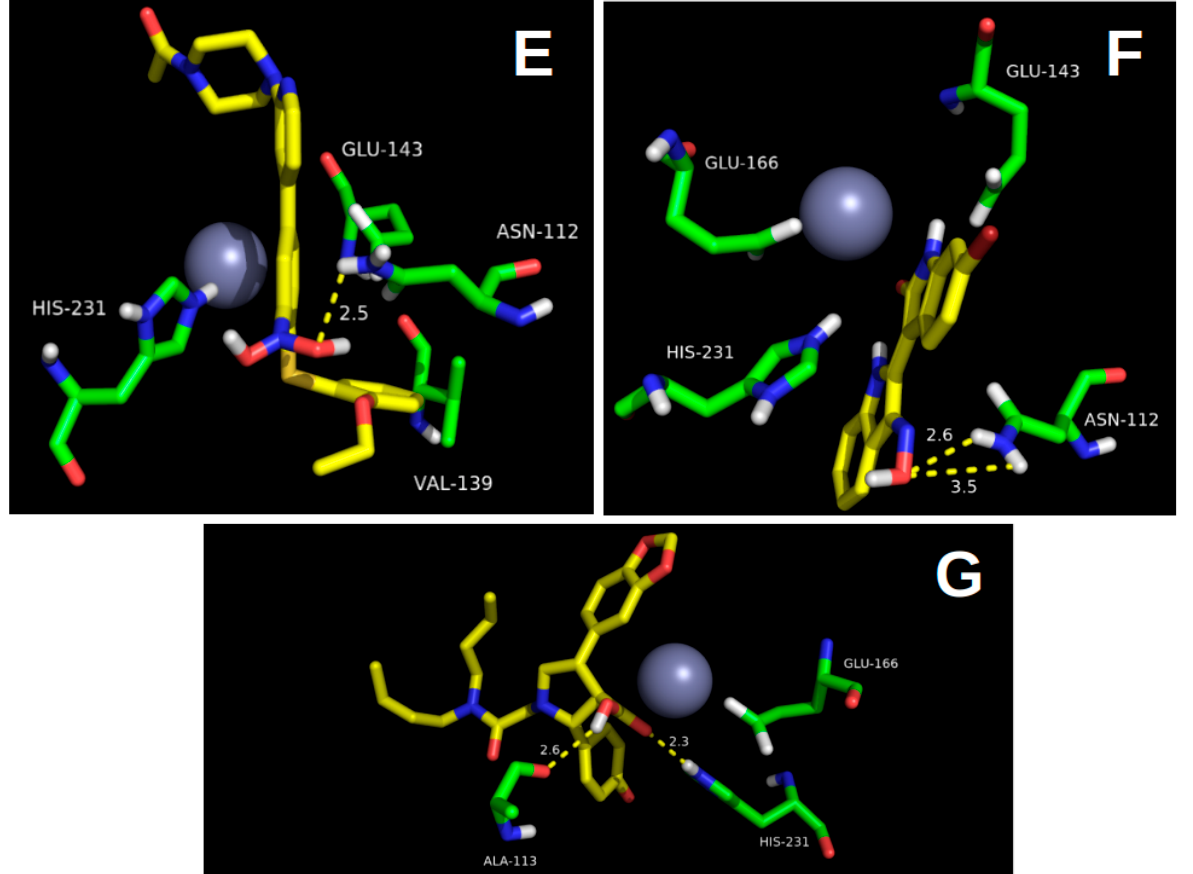
Figure 3. Binding modes’ structural details of the ligands designed in silico placed into the thermolysin active site: ( A ) Lig5H9 reference compound, ( B ) Lig783, ( C ) Lig1022, ( D ) Lig1392, ( E ) Lig2177, ( F ) Lig3444, and ( G ) Lig-6199. The right side corresponds to the 2D representation of the ligand’s interactions studied in the thermolysin active site. The grey spheres represent the Zn 2+ ion in the thermolysin active site.